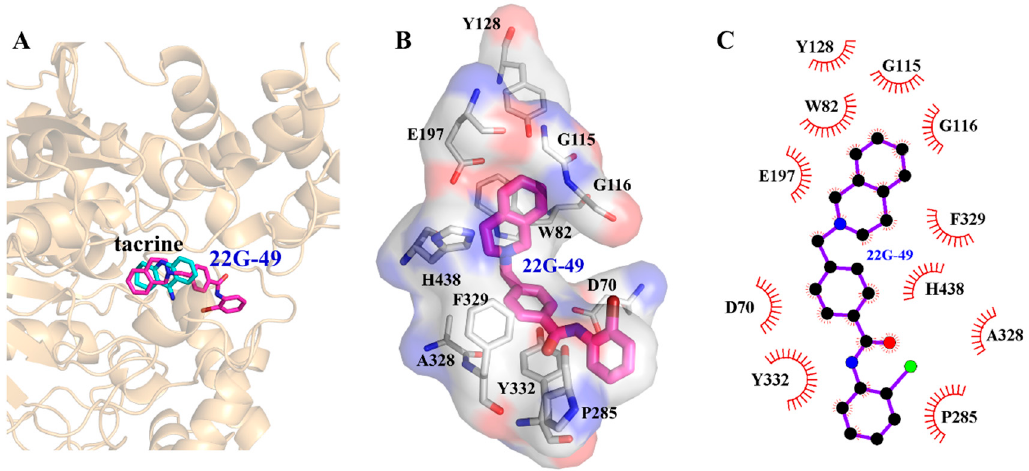
Figure 4. Predicted binding mode of 23 with BChE. ( A ) Superimposition of the binding modes of 23 and tacrine. BChE, 23 and tacrine are shown as light-orange cartoon, magenta, and cyan sticks. ( B ) Detailed interactions between 23 and BChE. Compound 23 is shown as magenta sticks, while the carbon atoms of the interacting residues are colored in white. ( C ) Key interactions involved in stabilizing 23 at the tacrine binding site.